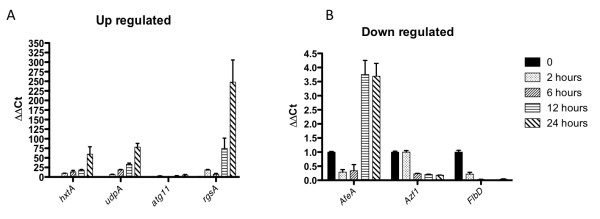
RT-PCR of novel transcripts affected by hypoxia. A. Four transcripts (Afu3g14170 (hxtA), Afu2g09590 (udpA), Afu3g11590 (atg11), Afu5g00900 (rgsA)) that were significantly increased using real time RT-PCR. B. Three transcripts (Afu5g12510 (afeA), Afu6g05160 (azf1), Afu1g03210 (flbD)), that were significantly decreased using real time RT-PCR. All reactions were performed on BioRad MyIQ real-time PCR detection system with IQ SYBR green supermix. The ΔΔCt method was used to combine three biological and 2 technical replicates for each transcript, using β-tubulin as the housekeeping gene for comparison.